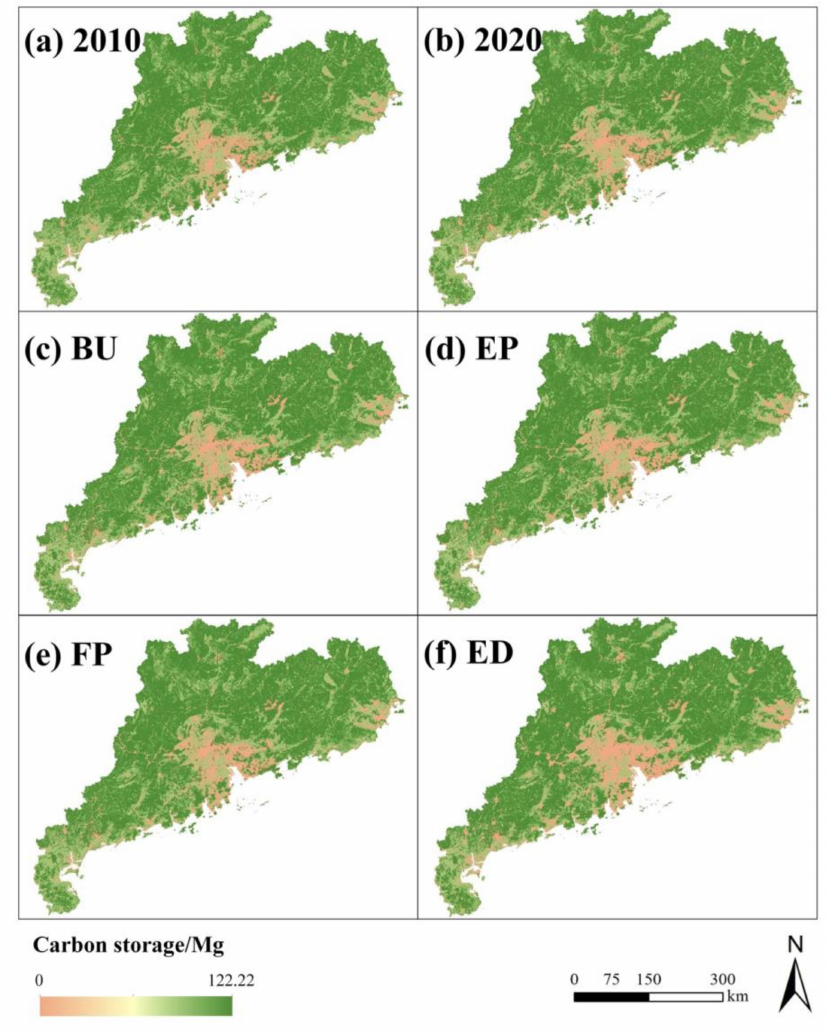
Figure 3. Spatial distribution of carbon storage in ( a ) 2010, ( b ) 2020, and 2030 under ( c ) BU, ( d ) EP, ( e ) FP, and ( f ) ED